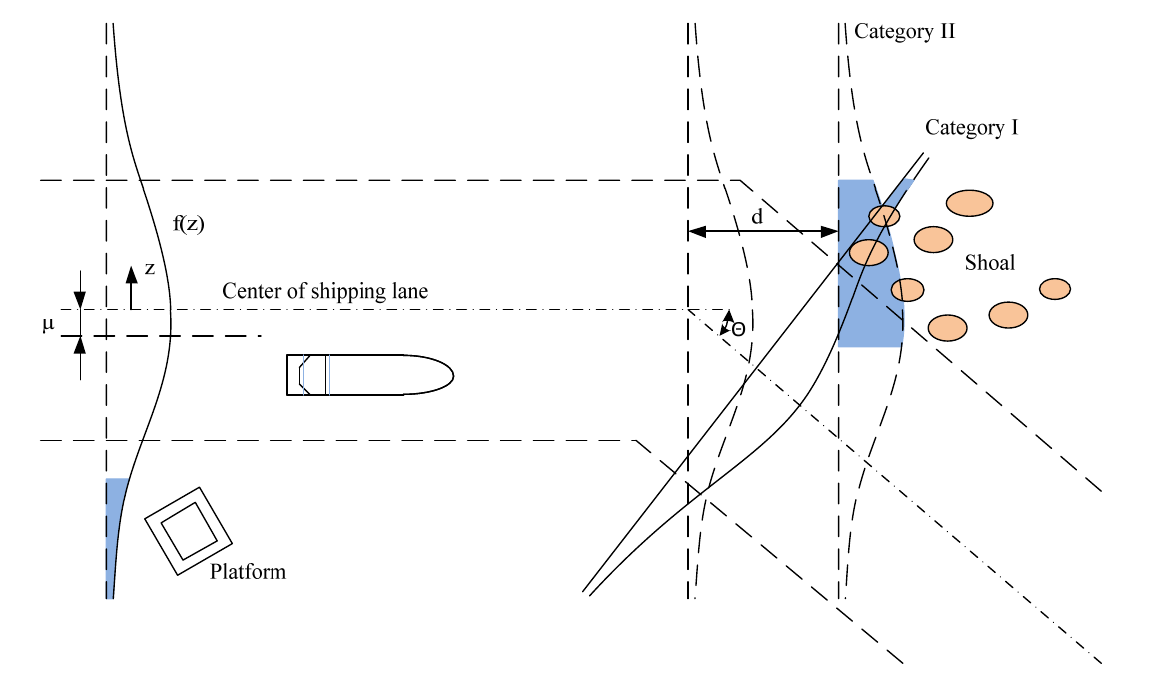
Figure 4. Distribution of ship traffic on a navigation route.